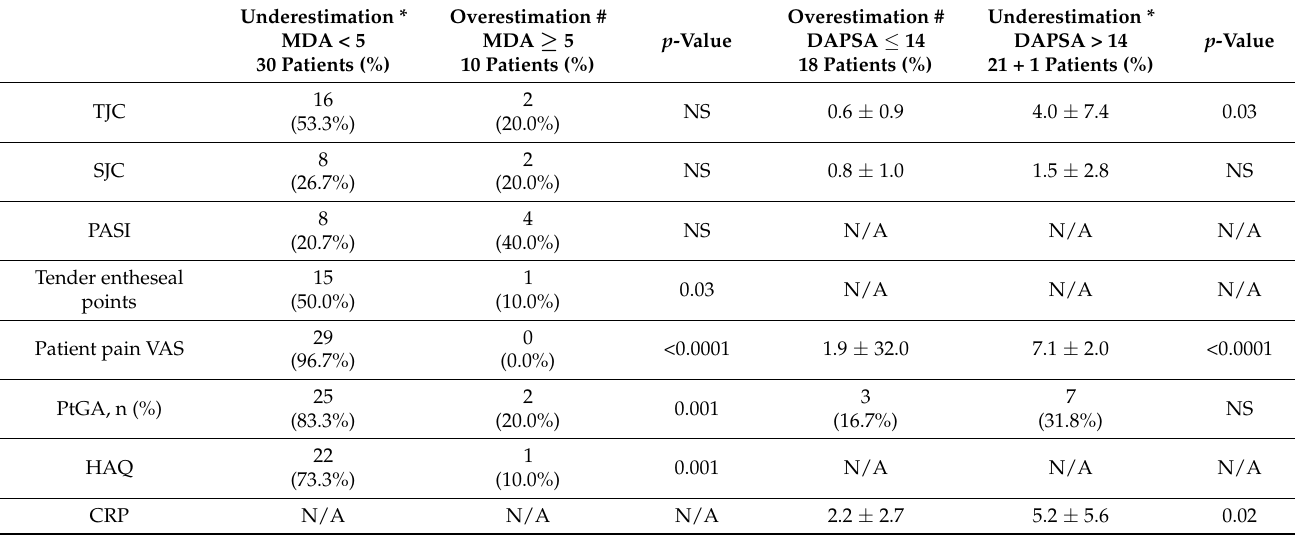
Table 3. Factors influencing discordance between physician clinical impression and individual MDA and DAPSA score